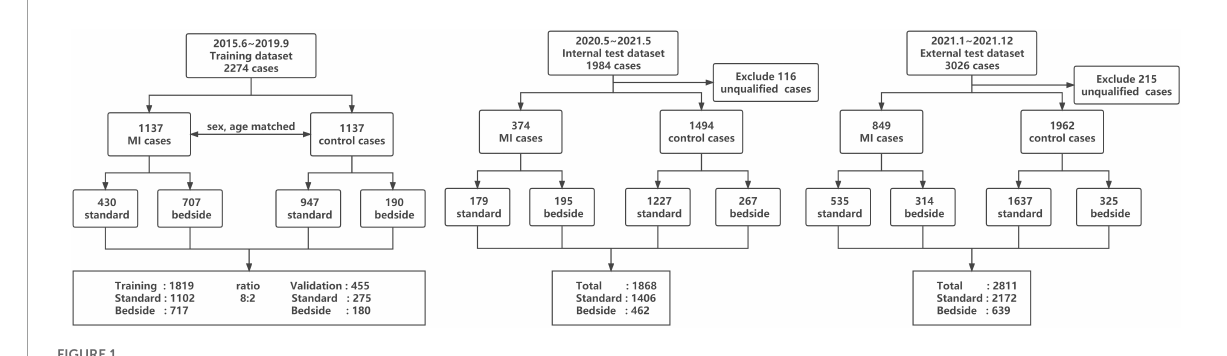
FIGURE1 Summary of number of echocardiograms used in this